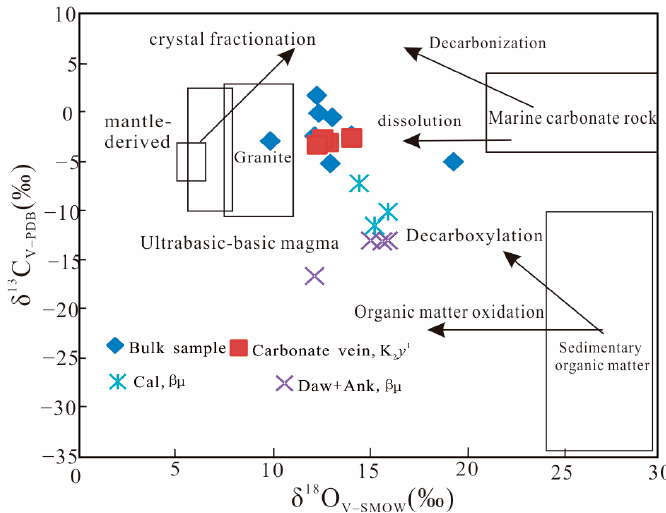
Figure 6. Diagram of C and O isotopic compositions of hydrothermal carbonates in Qianjiadian ore field (Basemap from [9]).